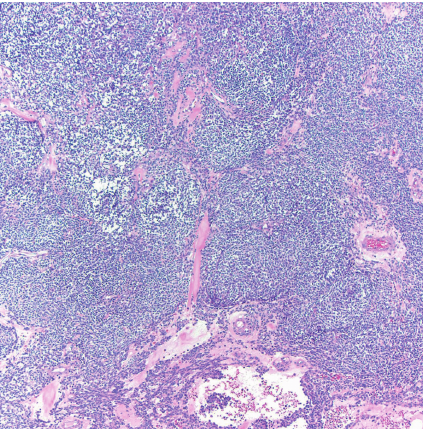
Figure 3: Medium power microscopic image demonstrating a diffuse sheet of medium-sized round blue cells within intermingled vessels (Hematoxylin and Eosin, 100x).